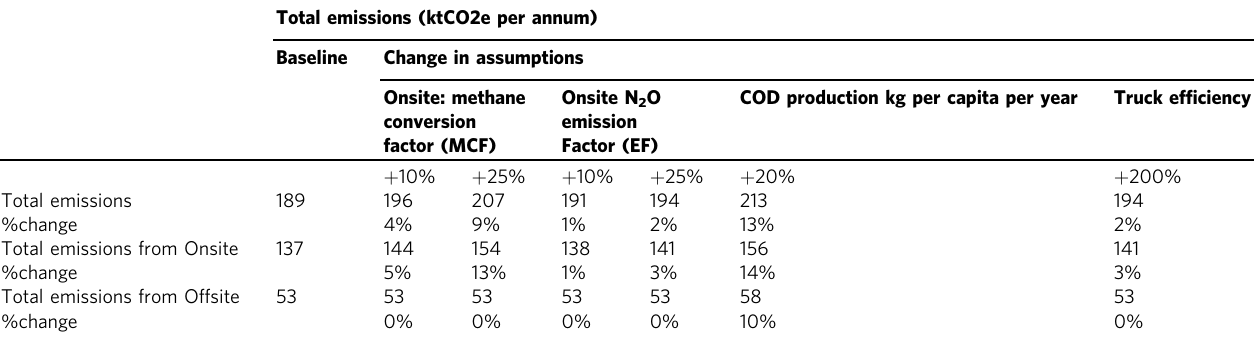
Table 6 Selected results from the sensitivity analysis for end-to-end GHG emissions from urban sanitation in Kampala,